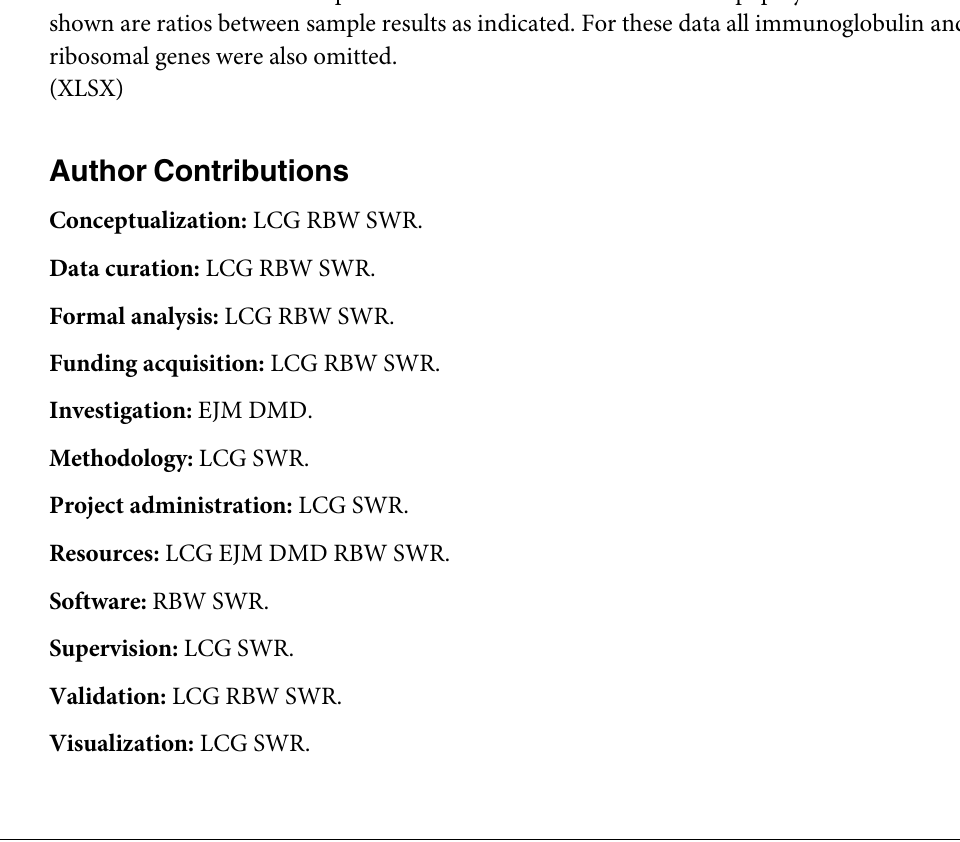
S1 Table. Lung epithelium RNA-Seq results summary. The gene transcript average read depth for those genes exceeding 200 mean counts between lung distal epithelium samples from the α 7 G or α 7 E260A:G exposed to intranasal saline or intranasal lipopolysaccharide. Also shown are ratios between sample results as indicated. For these data all immunoglobulin and ribosomal genes were also